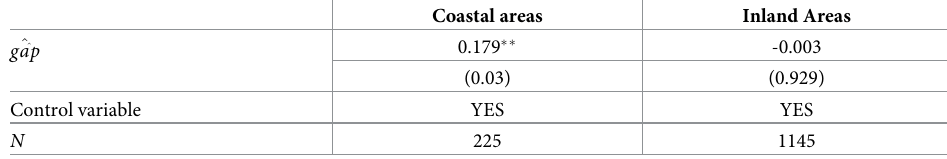
Table 9. Results based on coastal areas or inland areas.